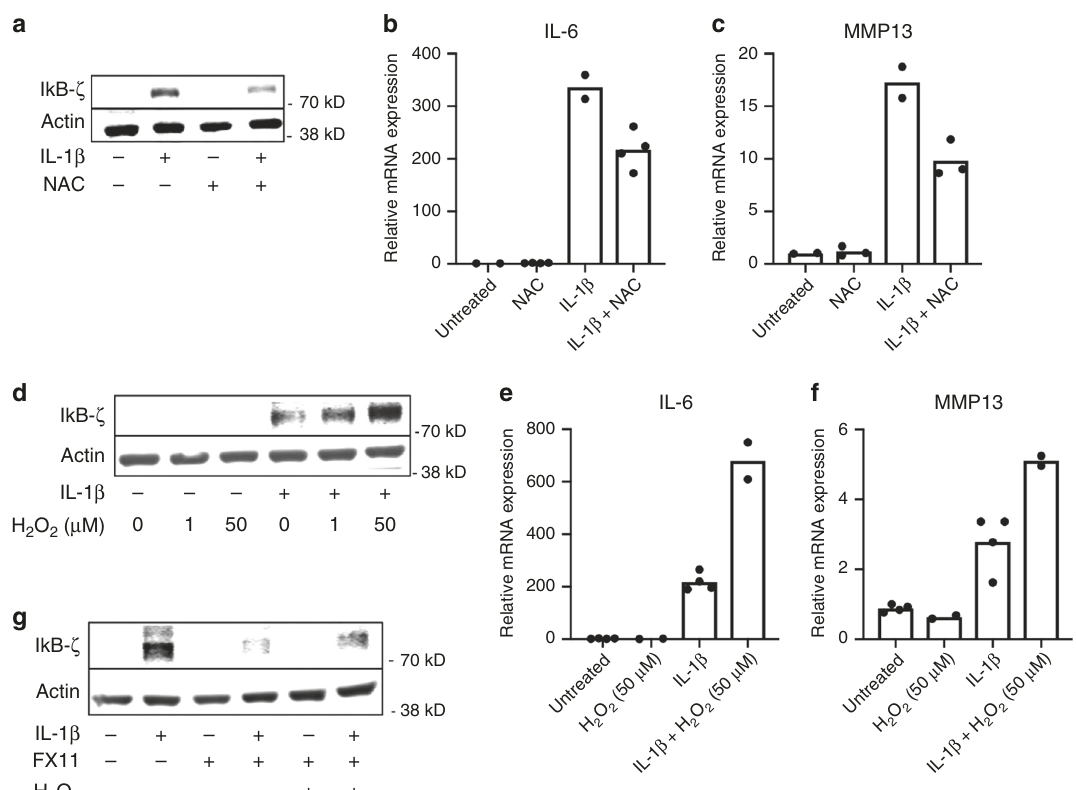
Fig. 6 ROS regulates stability of I κ B- ζ protein. a Chondrocytes were co-treated with IL-1 β (10 ng/mL) and N-acetylcysteine (3 mM) for 24 h. Western blotting was performed for I κ B- ζ . b , c Gene expression analysis for IL-6 and MMP13 was performed by qPCR. Results are representative of two out of three independent experiments, due to large biological variation in third experiment with similar trends. Bars represent mean of n = 2 independent experiments. d Chondrocytes were treated with increasing concentrations of Hydrogen peroxide in the presence or absence of IL-1 β for 24 h. Western blotting was performed for I κ B- ζ . Image representative of one of three experiments. e , f Gene expression of IL-6 and MMP13 was measured by qPCR. Results are representative of one experiment out of three displaying similar trends but with large biological variations in gene expression. Bars represent mean of technical replicates from one experiment. g Chondrocytes were then treated with FX11 (40 μ M) in the presence or absence of H 2 O 2 (50 μ M) and IL-1 β (10 ng/mL) for 24 h. Western blotting was performed for I κ B- ζ . Image representative of one of two